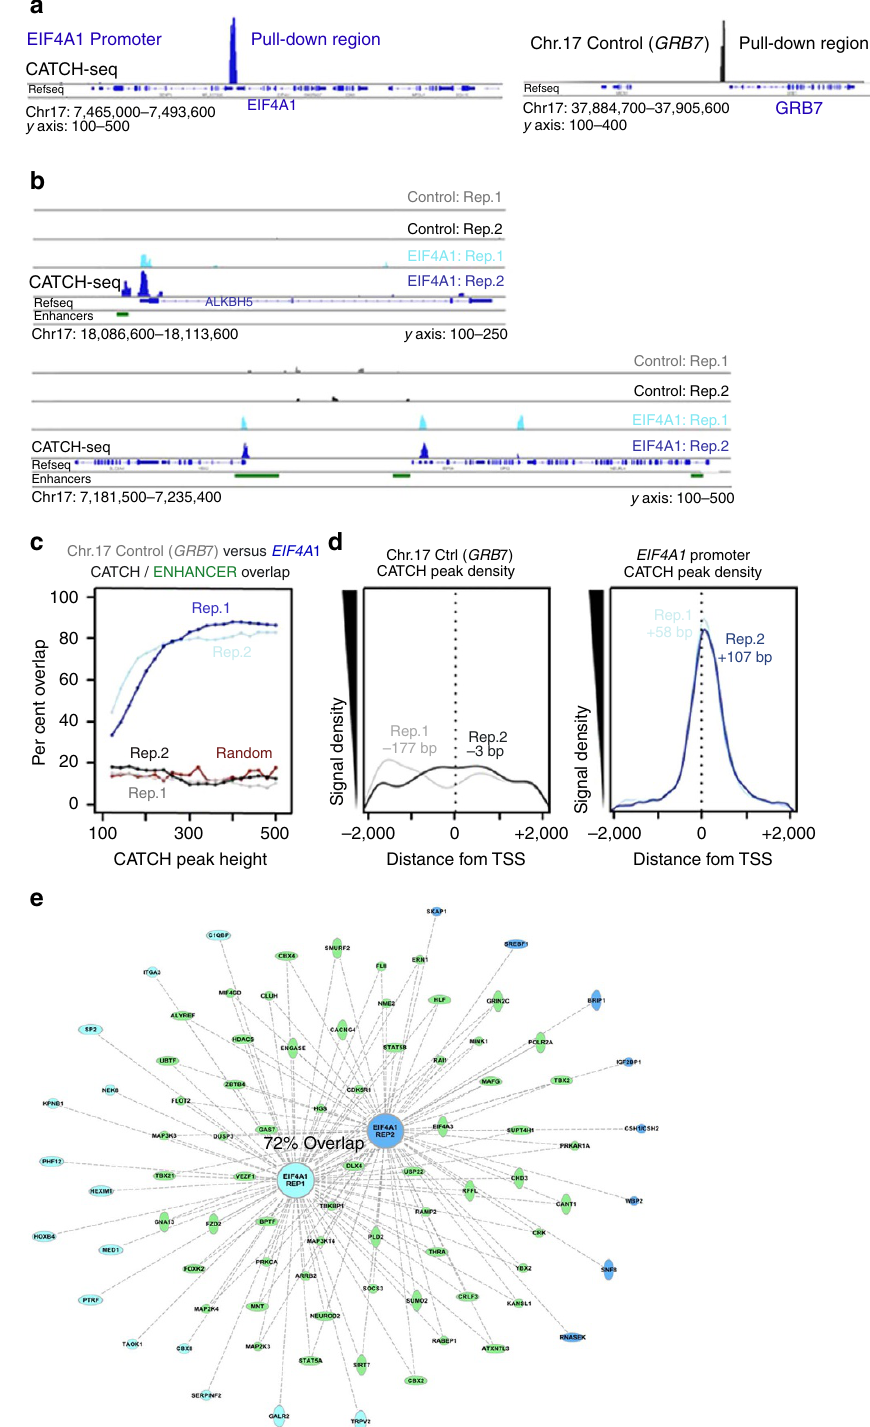
Figure 3 | CATCH-seq demonstrates specificity and reproducibility. y axis labels below IGV histograms represent number of sequencing reads after background subtraction. ( a ) The promoter region of EIF4A1 was directly captured via CATCH, along with the promoter region of GRB7 , which served as a negative control for DNA–DNA interaction. ( b ) Examples of raw CATCH-seq histograms (background-subtracted) demonstrating the locations of peaks near gene promoters, and the reproducibility of multiple replicates. All histograms are on the same scale. ( c ) EIF4A1 promoter (blue) CATCH-seq interactions significantly overlap with enhancer marks (H3K4me1, H3K27ac) compared with control (greyscale), whose overlap is no greater than statistically random (red); the frequency of these overlaps increase with peak height. ( d ) The CATCH-seq interactions of the EIF4A1 promoter occur, on average, between 50 and 100bp downstream of TSSs on chromosome 17. There was no discernable pattern near TSSs for the control pulldown. Both density plots have identical x and y axes. ( e ) Ingenuity pathway analysis (IPA) analysis detailing specific gene promoters that demonstrated physical interaction with the EIF4A1 promoter. There was a remarkable 72% overlap between the CATCH-seq replicates (shared interactions: green, unique interactions: light and dark blue). NATURE COMMUNICATIONS|7:12893|DOI: